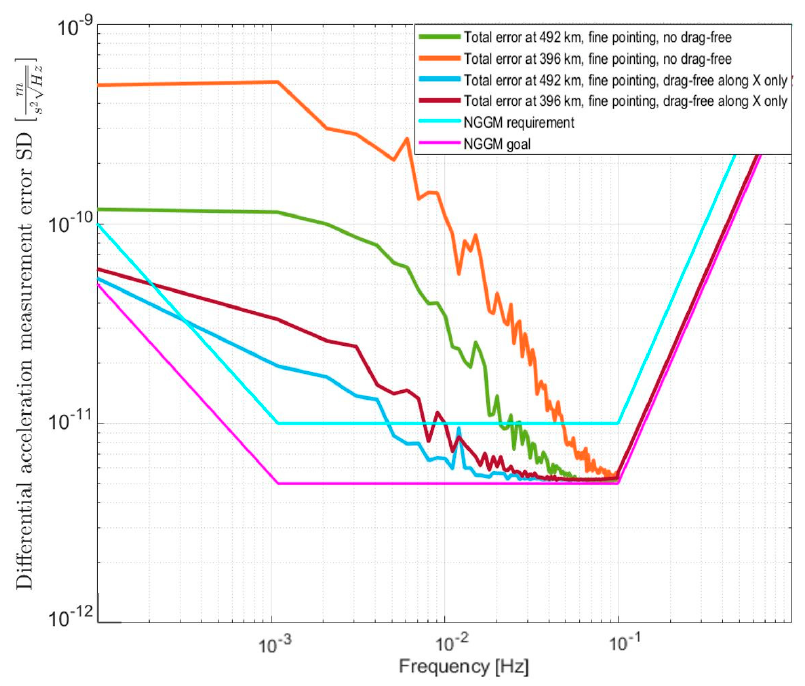
Figure 18. Performance for scenarios with degraded drag-free control (either no drag-free control along the flight direction, satellite X axis, or along any of the axes) at the two orbital altitude regimes considered as 396 and 492 km.